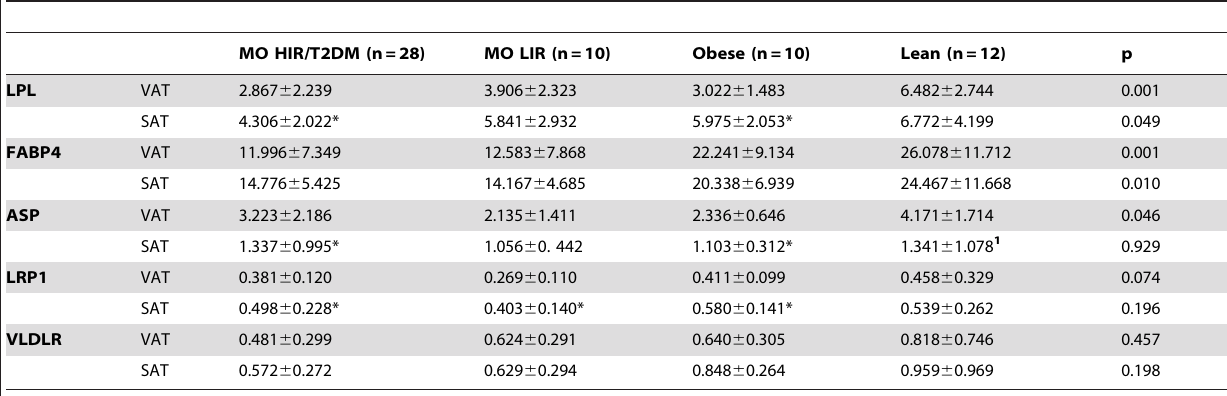
Table 2. mRNA expression levels of the genes studied in subcutaneous adipose tissue and visceral adipose tissue in the lean healthy controls, obese subjects and morbidly obese patients.